Question: Provide a publication-style caption for this figure.
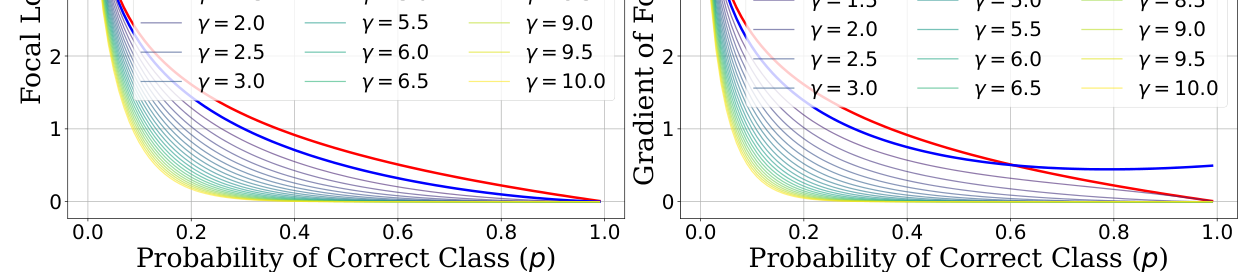
Answer: Changes in loss and gradient with respect to model prediction probability p for different values of the hyperparameter γ in focal loss. The vertical axes represent loss and gradient, respectively, and the horizontal axis represents model prediction probability p. Focal loss coincides with cross-entropy when γ = 1. For 0 < γ < 1 , as shown in the right figure, the gradient does not converge (having an effect opposite to the original intention). When γ ≥1, the gradient and loss for well-classified samples (p close to 1) are smaller than those for cross-entropy.